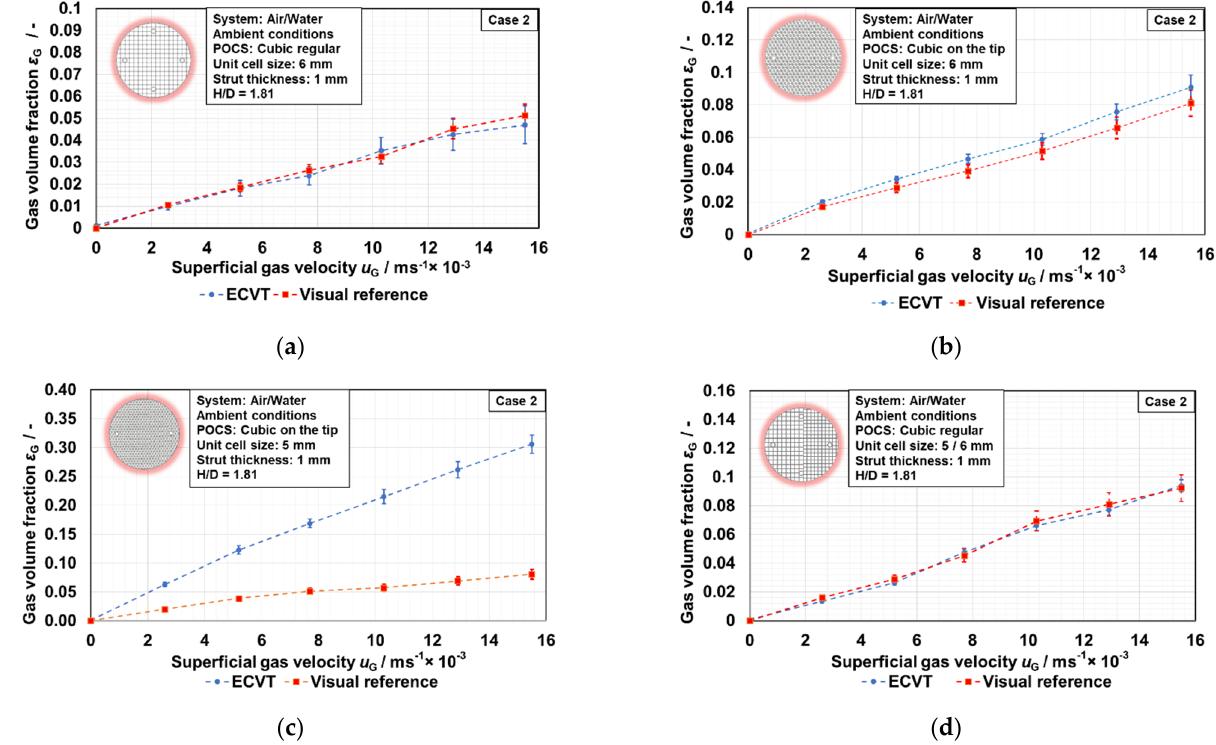
Figure 6. Case 2 overall gas holdup from ECVT data versus volume expansion method; ( a ) 6 mm cubic regular; ( b ) 6 mm cubic on the tip; ( c ) 5 mm cubic on the tip; ( d ) 5 mm/6 mm modified structure regular.